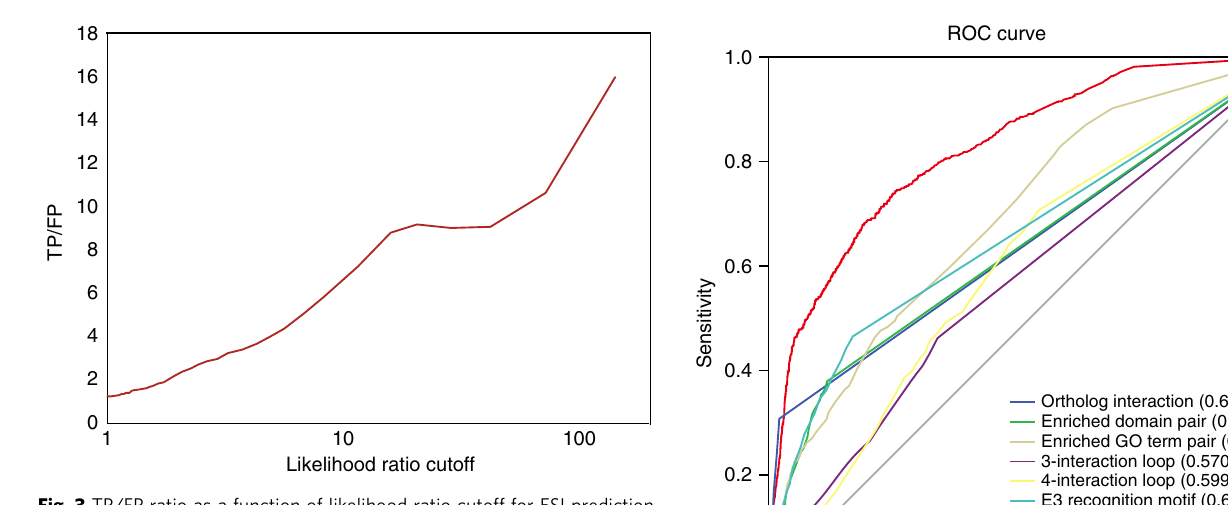
Fig. 3 TP/FP ratio as a function of likelihood ratio cutoff for ESI prediction. The ratio of the true to false positive (TP/FP) was plotted as the function of the cutoff of likelihood ratio. The number of true positives and false positives were from the fi vefold cross-validation (see text for details)